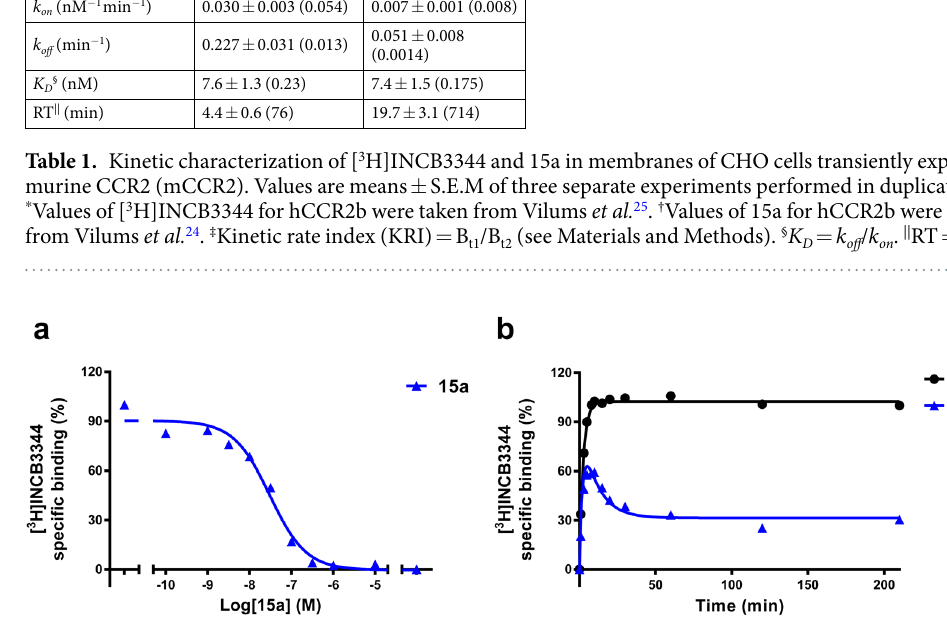
Figure 3. Characterization of 15a in murine CCR2. ( a ) Displacement of [ 3 H]INCB3344 binding from CHO cell membranes transiently expressing murine CCR2 at 25 °C, upon addition of increasing concentrations of compound 15a. ( b ) Competition association of 5 nM [ 3 H]INCB3344 binding to membranes of CHO cells transiently expressing murine CCR2 at 25 °C, in the absence or presence of 30 nM 15a. Data were fitted to the competition association model of Motulsky and Mahan 27 . Graphs shown are representative from one experiment performed in duplicate. Data for kinetic experiments (n = 3) are presented in Table